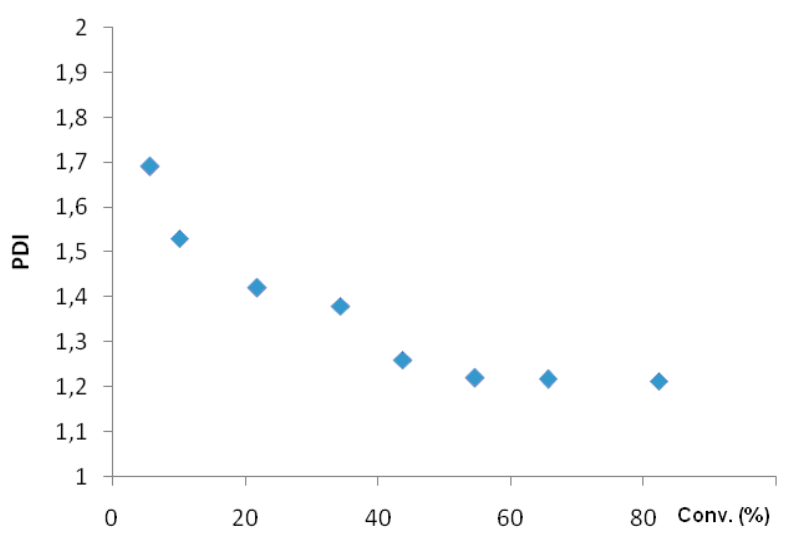
Figure 5. Evolution of polydispersity index with conversion: [NVK] in 1,4-dioxane at 70